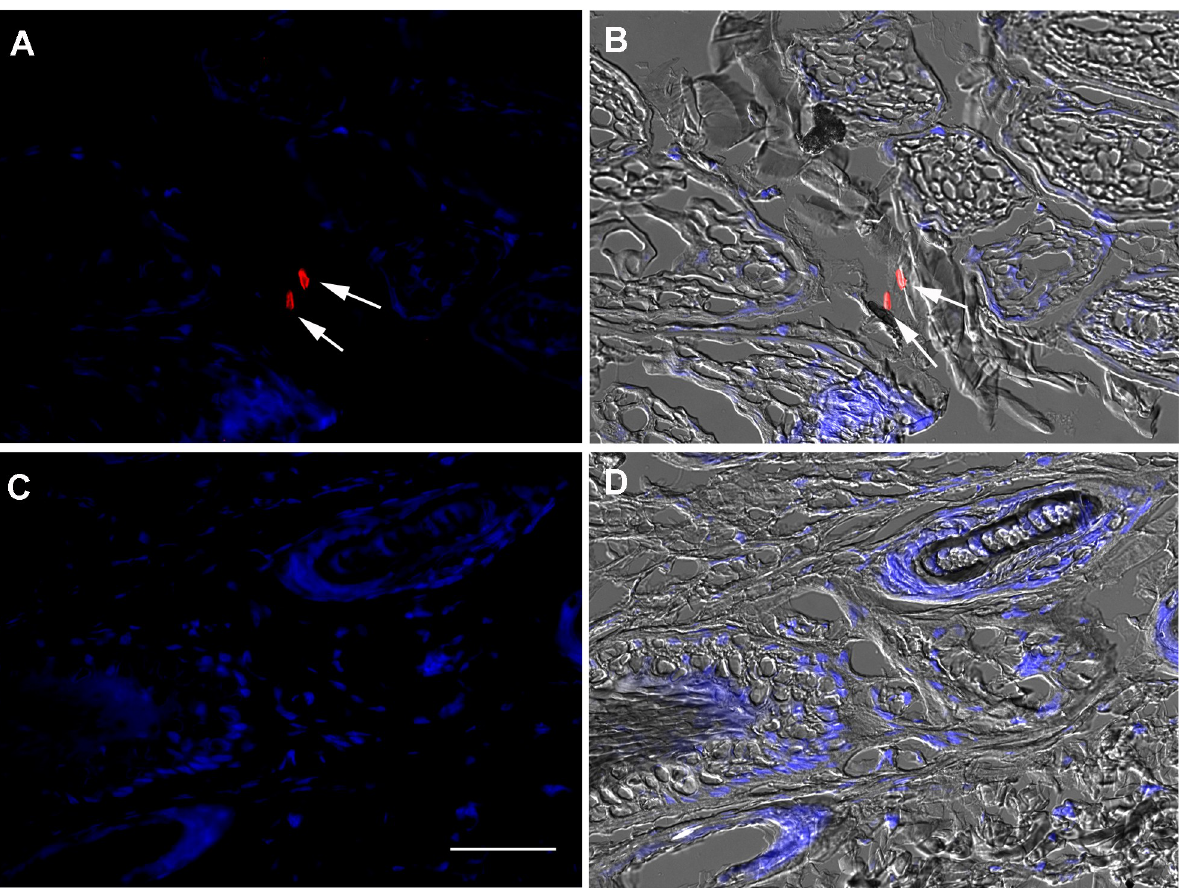
Fig 5. Immunolocalization of Mycobacterium LAM cell wall antigen in skin biopsies from a rabbit infested with Amblyomma sculptum larvae. Biopsies of bite sites collected from rabbits following 5 days’ infestation with larvae hatched from eggs laid by A . sculptum females after artificial feeding with uninfected (C, D) or M . leprae -infected (A, B) rabbit blood were fixed and sectioned. Panels A and C were generated through the merging of red channel image (anti-LAM + anti-mouse Alexa 594) with blue channel image (DAPI nuclear staining). Panels B and D were generated by merging with differential interference contrast images. In panels A and B, LAM-positive bacilli (arrows) can be seen in the area where the larval hypostome penetrated the rabbit skin. These images are representative of four biopsies obtained from two independent experiments. Scale bar represents 40 μ